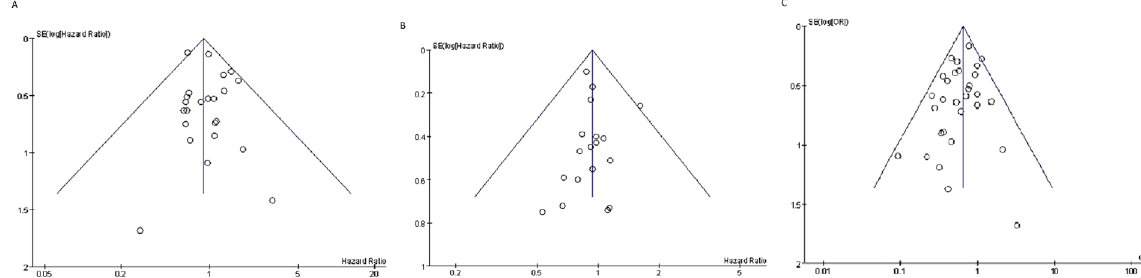
Figure 3. Funnel plots for publication bias. The funnel plot revealed no publication bias. ( A ) 3-OS; ( B ) 5-OS; ( C ) overall